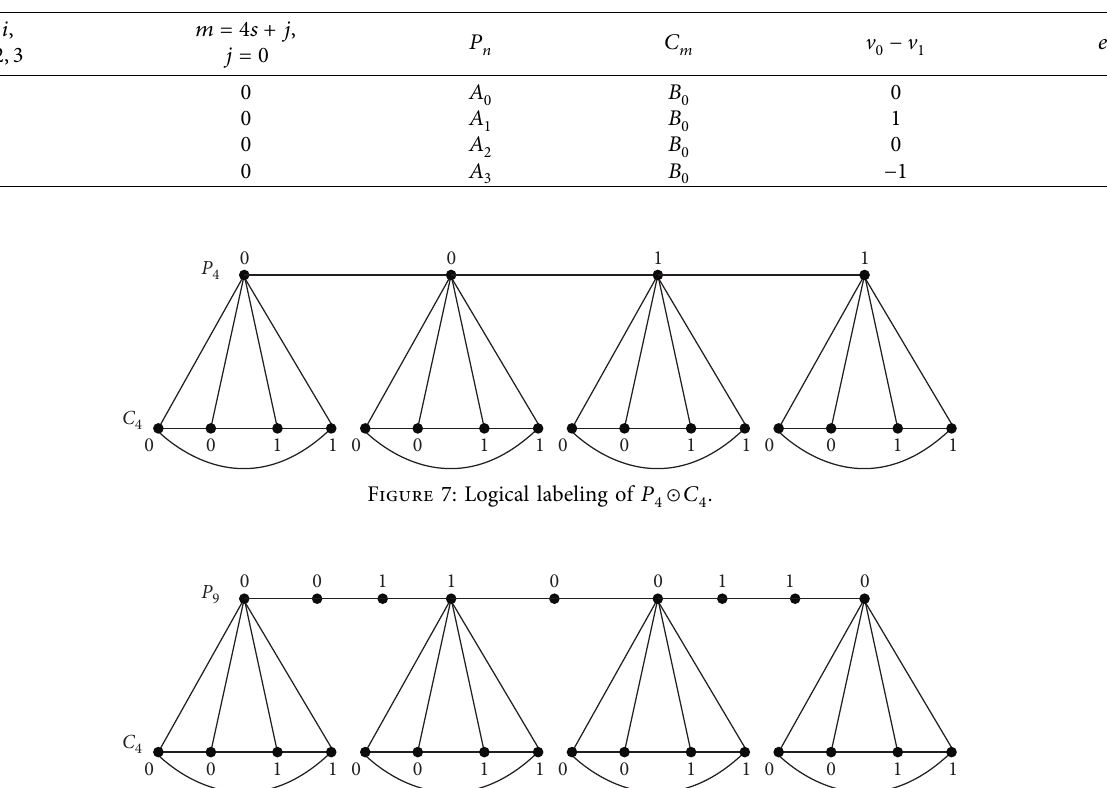
Figure 8: Logical labeling of P